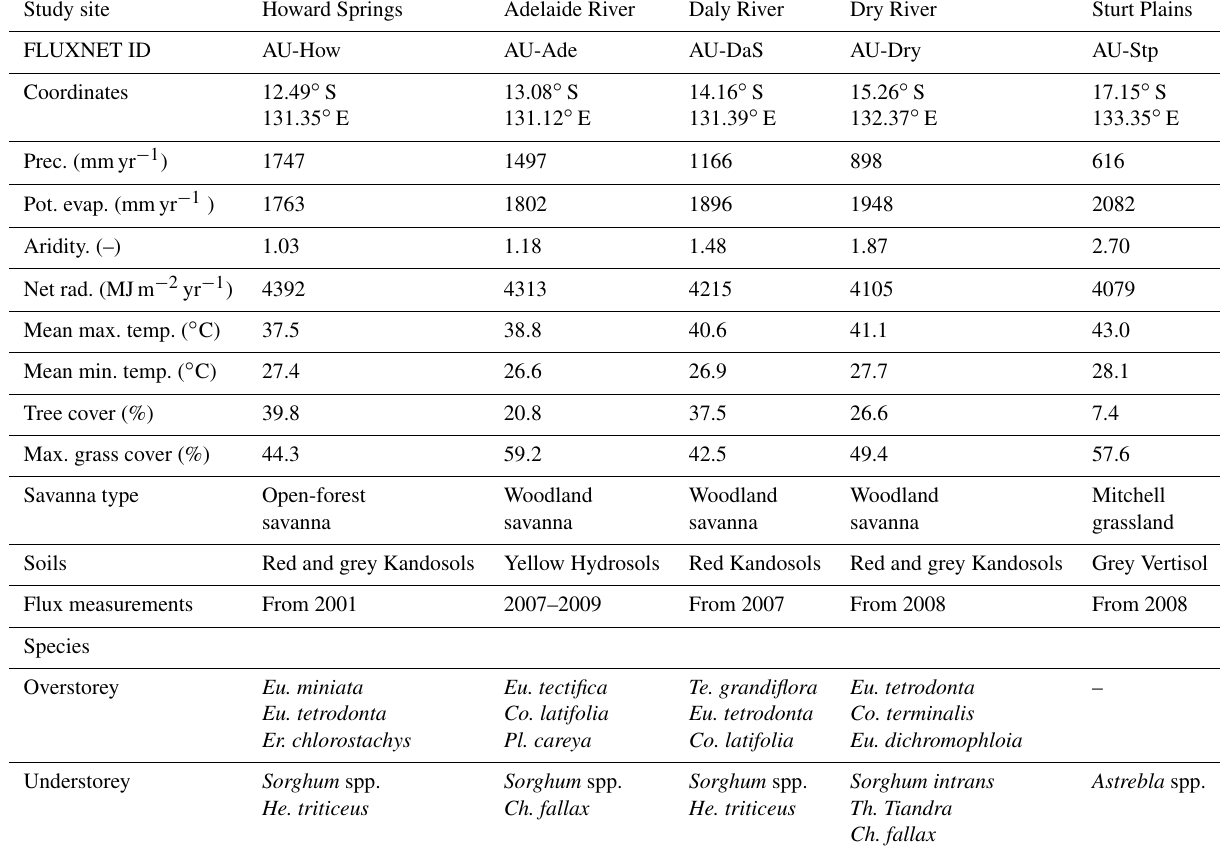
Table 1. Characteristics of the study sites along the North Australian Tropical Transect; vegetation data from Hutley et al. (2011) and Whitley et al. (2016), with Eucalyptus (Eu.), Erythrophleum (Er.), Terminalia (Te.), Corymbia (Co.), Planchonia (Pl.), Themeda (Th.), Hetropogan (He.), and Chrysopogon (Ch.). Meteorological data are taken from the SILO Data Drill (Jeffrey et al., 2001) for the model periods of 1 January 1980 until 31 December 2017, with the potential evaporation calculated according to the FAO Penman–Monteith formula (Allen et al., 1998). The ratio of the net radiation R n to the latent heat of vaporization λ multiplied by the precipitation P is defined here as the aridity R n /λP . Tree cover is determined as the minimum value of the mean monthly projective cover based on fPAR observations (Donohue et al., 2013). The maximum grass cover was found by subtracting the tree cover from the remotely sensed projective